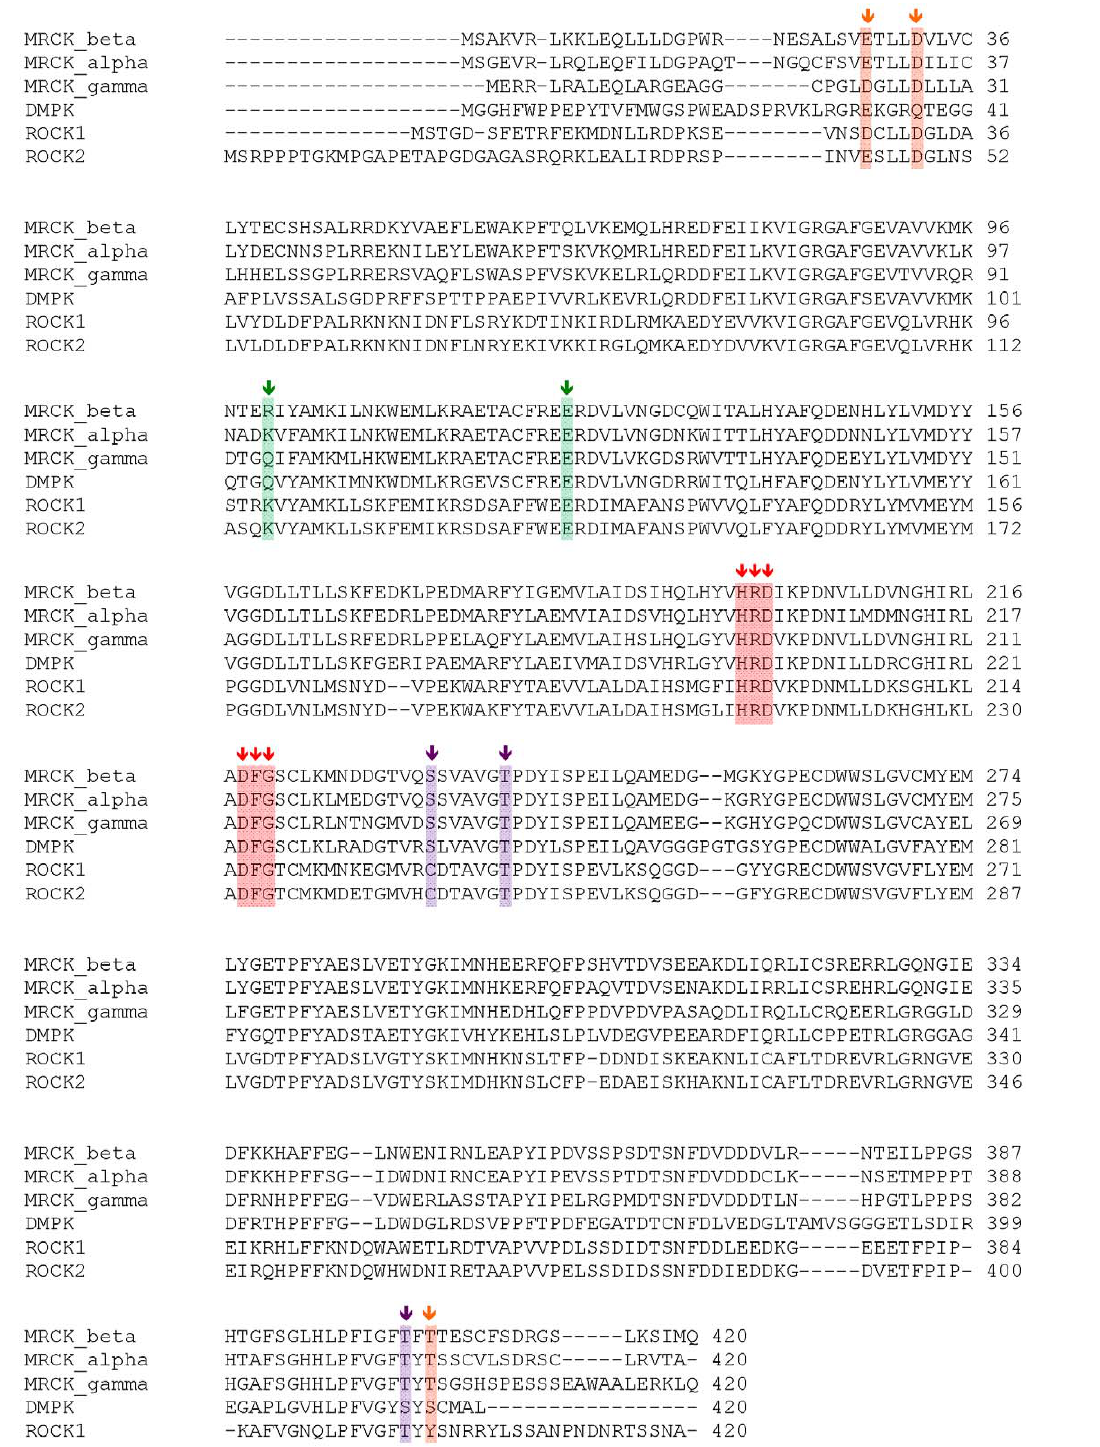
Figure 6. Sequence alignment of MRCK b and the most closely related AGC kinases. Sequences have been truncated after the C-terminal lobe. The conserved HRD and DFG motifs have been highlighted with red arrows, and the conserved salt bridge at the active site with green arrows. Predicted phosphorylation sites have been indicated with magenta arrows, and the residues involved in hydrogen bonds between the C- and N- termini at the dimerization domain are indicated by orange arrows. doi:10.1371/journal.pone.0024825.g006 are fully conserved – therefore, selectivity for a specific isoform of Selectivity over ROCK isoforms, on the other hand, would MRCK is unlikely to be achievable by ATP-competitive seem more feasible considering the differences at the structural inhibitors. level. ROCK2 and MRCK b are approximately 46% and 75%